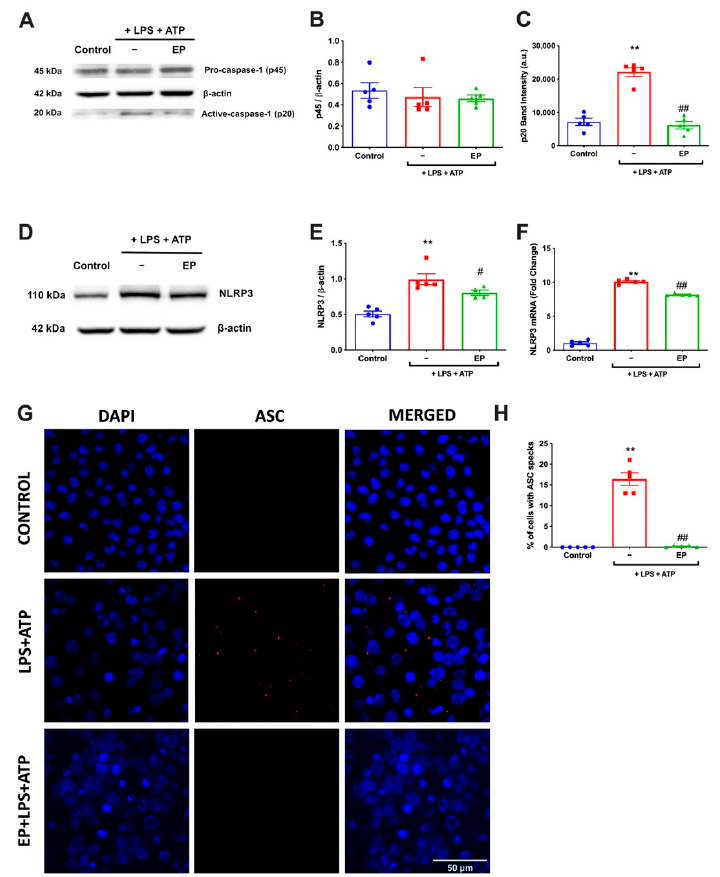
Figure 2. EP reduced NLRP3, caspase-1, and ASC speck formation. N9 microglial cells were pretreated with EP (10 mM) for one hour, then treated with LPS (1 μ g/mL) for four hours, and ATP (5 mM) for 1 h. ( A – C ) Pro-caspase-1 shows no difference among groups. EP reduced cleaved caspase-1 in EP-pretreated cells compared to LPS- and ATP-induced cells. ( D – F ) EP suppressed NLRP3 on both protein and mRNA levels compared with LPS- and ATP-induced cells. ( G ) ASC speck formation was determined by confocal microscopy. ( H ) EP significantly prevented ASC speck formation compared to LPS- and ATP-induced cells. Data are presented as mean ± S.E.M, n = 5. ** p < 0.01compared to control and # p < 0.05, ## p < 0.01 compared to LPS- and ATP-induced cells.